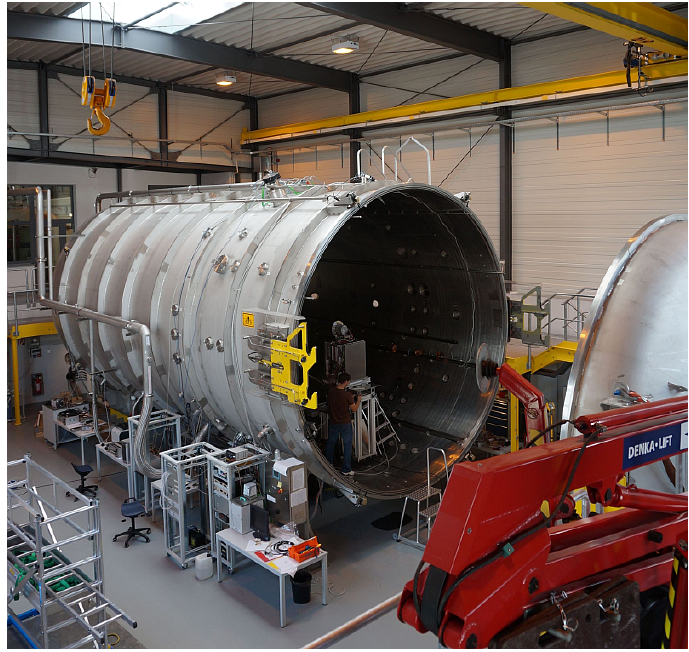
Figure 1: View into the open vacuum chamber of the STG-ET